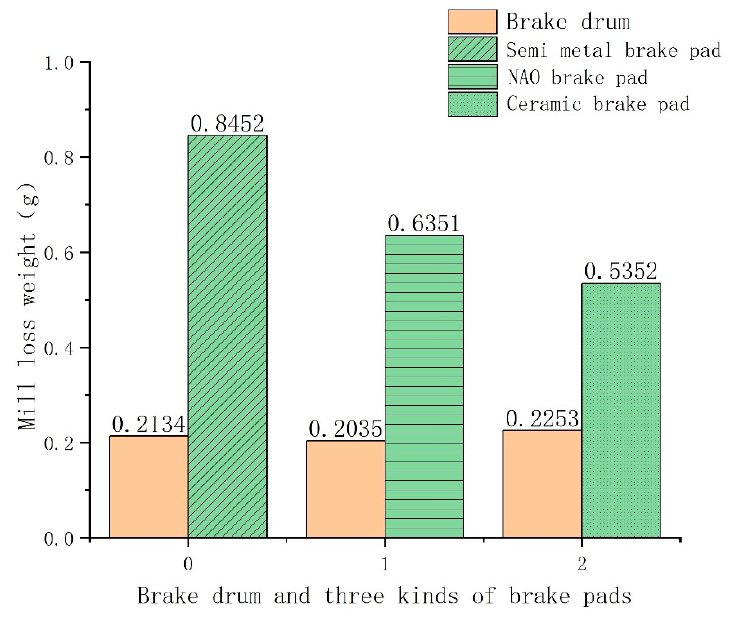
Figure 8. Wear test results of the blank sample and different brake pads.